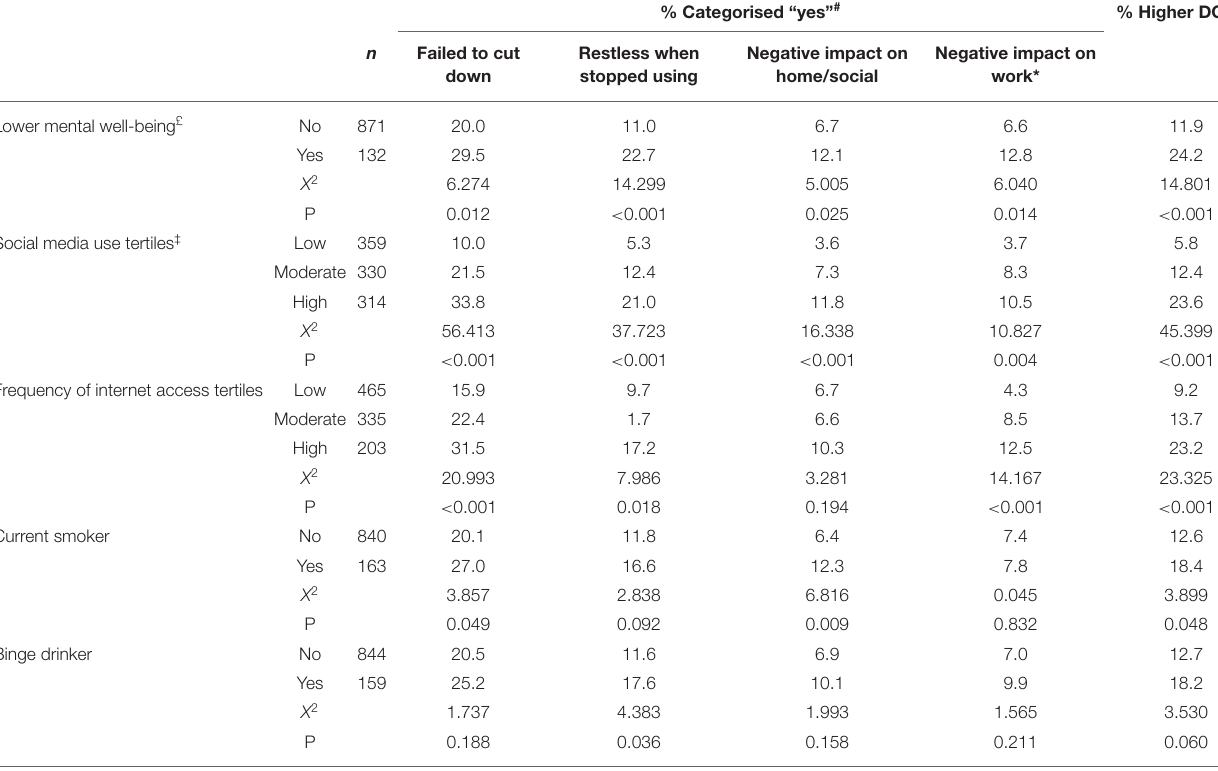
TABLE 2 | Digital Overuse and Addiction Traits (DOAT) by mental well-being, online activity, current tobacco smoker, and binge drinker.